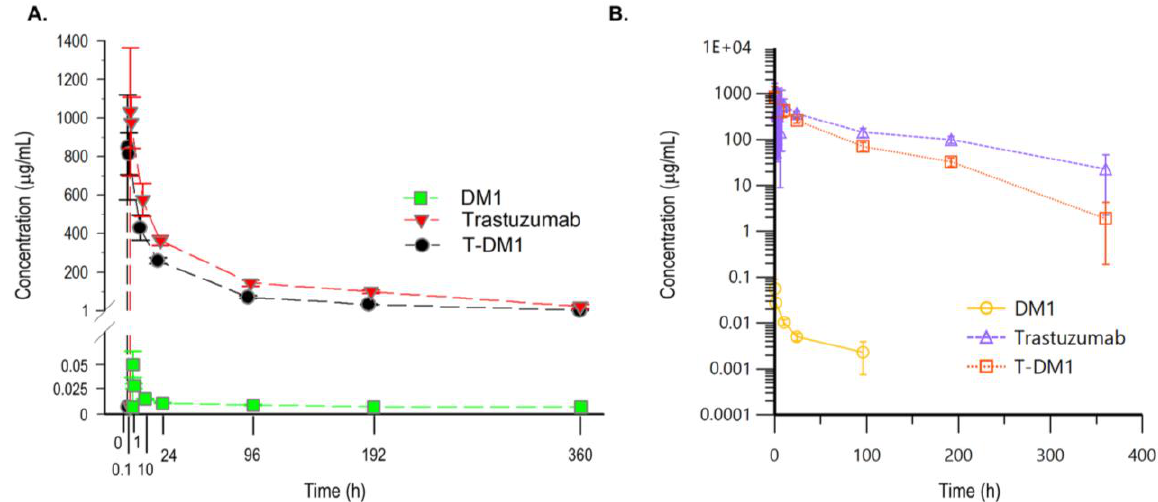
Figure 2. Pharmacokinetic profile of T-DM1 after a single intravenous injection of T-DM1 (20 mg/kg) in Sprague‒Dawley rats. Sampling time points included predose (0 h) and 5 min, as well as 1, 10, 24, 96, 192, and 360 h post injection. Representative mean concentration – time graphs are depicted in ( A ) concentration – time curves and ( B ) Concentration in log scale – time curves. The concentration of DM1 in rat plasma was analyzed with LC – MS/MS (green closed square for ( A ), yellow open circle for ( B )). T-DM1 was separately analyzed by targeting DM1 for the detection of DM1-conjugated trastuzumab (closed circle for ( A) , red open square for ( B )) or by targeting trastuzumab for the detection of total trastuzumab regardless of DM1 conjugation (red closed triangle for ( A) , purple open triangle for ( B )). The results are shown as the mean ± standard deviation.